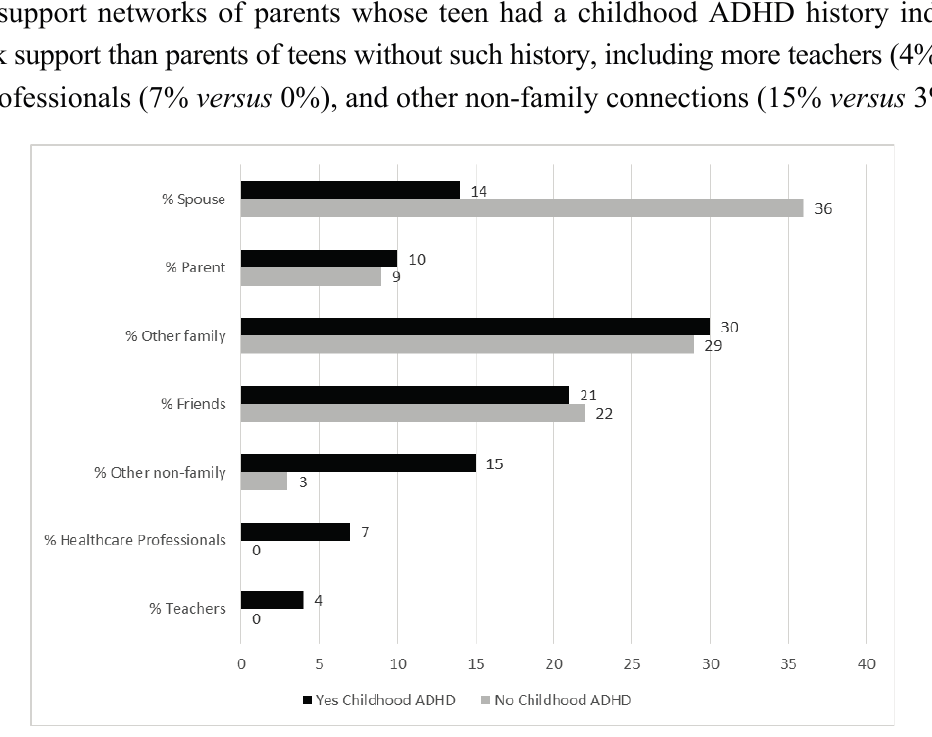
Figure 1. Percent of network composition by support type, by ADHD